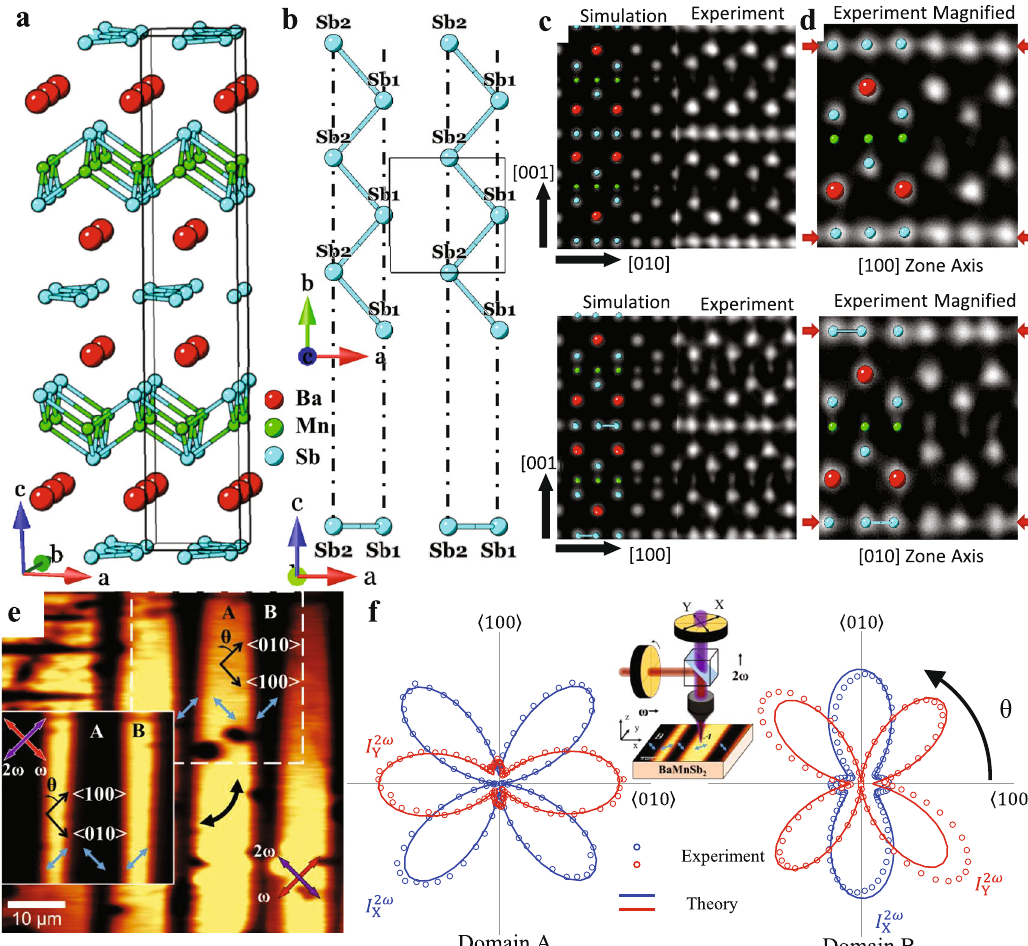
Fig. 1 Structure determination of BaMnSb 2 . a The schematic showing the I2mm crystal structure of BaMnSb 2 . b Schematic of the Sb zig-zag chain layer from [001] and [010] axis formed due to orthorhombic distortion. c Simulated (left panel) and experimental (right panel) HAADF-STEM images along the [100] and [010] zone axes. d Magni fi ed experimental HAADF-STEM image with superimposed atom structures highlighting the orthorhombic distortion. The red arrows point to the Sb layer and show how Sb atoms in the zig-zag chain layer form dimmer-like structure in the STEM image taken along the [010]-zone axis. e Optical SHG microscopy of polar domains. The polar axes are indicated by the light blue arrows. The imaging light polarization conditions for the ω and the 2 ω frequencies are indicated by red and purple arrows. The crystallographic axes in each domain are indicated. The light polarization conditions for the inset image are orthogonal to the corresponding conditions for the main image, hence the reversal in contrast that is observed. f SHG polarimetry experiments (circles) in domains A and B indicated in panel ( e ), and the corresponding theoretical fi ts (solid lines) are shown for two different SHG polarization directions indicated in the inset schematic. Details of the fi t based on 2 mm point group symmetry are given in Supplementary Note